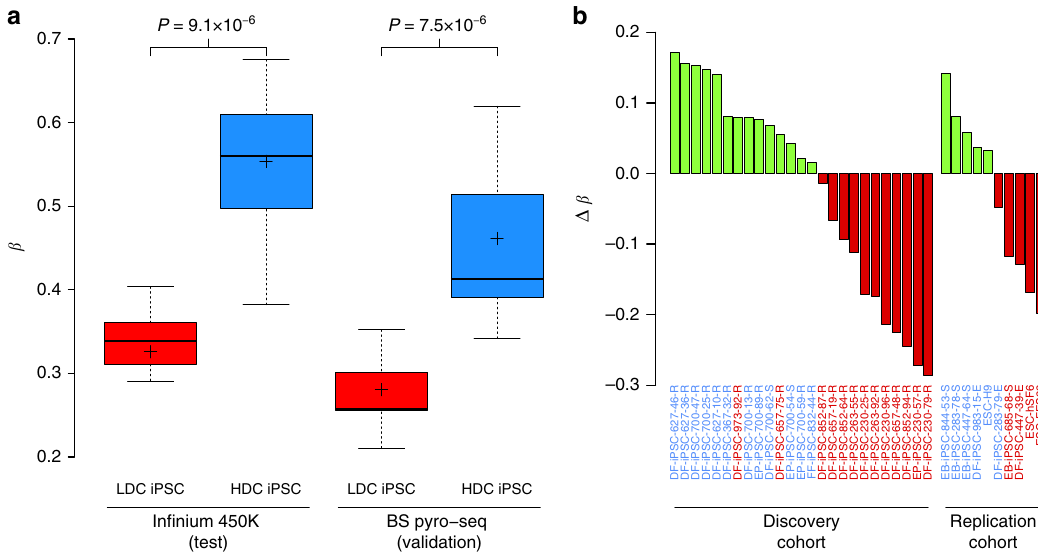
Figure 3 | Translation and simplification of a discriminative non-CG assay. We selected 9 of the top 200 non-CG MVPs and aggregated methylation levels for the two hiPSC phenotypes. ( a ) Separation between the two hiPSC phenotypes was maintained and independently validated with bisulfite pyrosequencing. Mean methylation levels are indicated by cross-hairs; P -values derived by two sample t -tests. ( b ) Sample-specific deviations from an endodermal differentiation capacity threshold in the discovery and replication cohorts. The endodermal differentiation capacity threshold ( b mean ¼ 45.8%) is defined as the midpoint between the upper (LDC) and lower (HDC) 95% CIs of mean non-CG levels in the discovery cohort for the nine-probe assay. This threshold correctly identifies 23 of 25 hiPSC lines in the discovery cohort; this finding was replicated in 3 hESC lines and 7 hiPSC lines derived from additional donor cell types and additional reprogramming methods from additional labs. Green bars, HDC (predicted); red bars, LDC (predicted); blue sample labels, HDC (phenotyped); red sample labels, LDC functional effect of occluded DNA-binding proteins in quantita- tive knockdown paradigms to simulate the intermediately methylated states seen at non-CG loci in pluripotent stem cells.